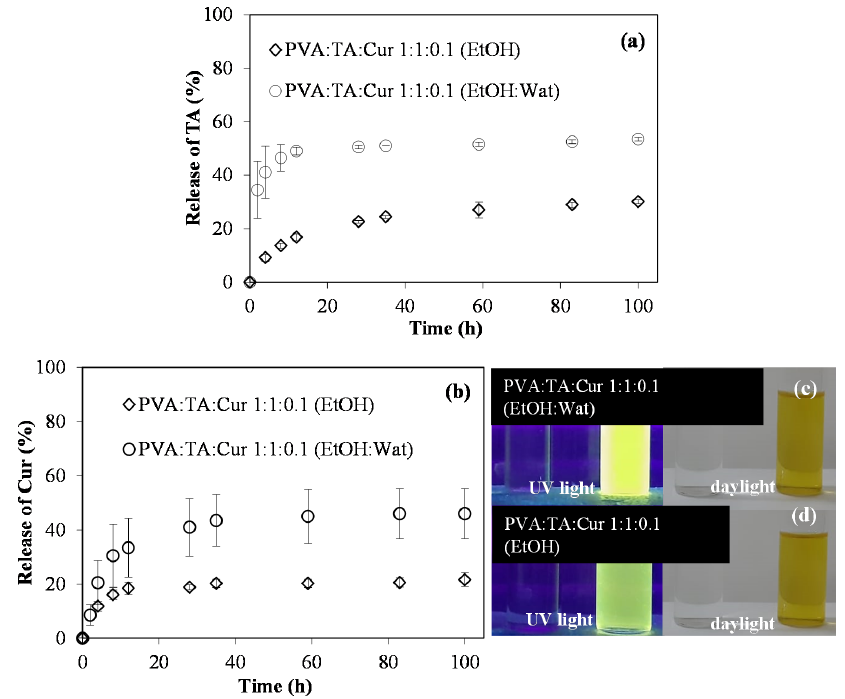
Figure 4. TA and Cur release profiles from PVA:TA:Cur 1:1:0.1 cryogel composites, (a) TA release profiles in EtOH and EtOH:Wat by UV-Vis spectroscopy, and (b) Cur release profiles in EtOH and EtOH:Wat by fluorescence spectroscopy. Digital camera images of these cryogels under (c) 366 nm UV light, and (d) daylight.